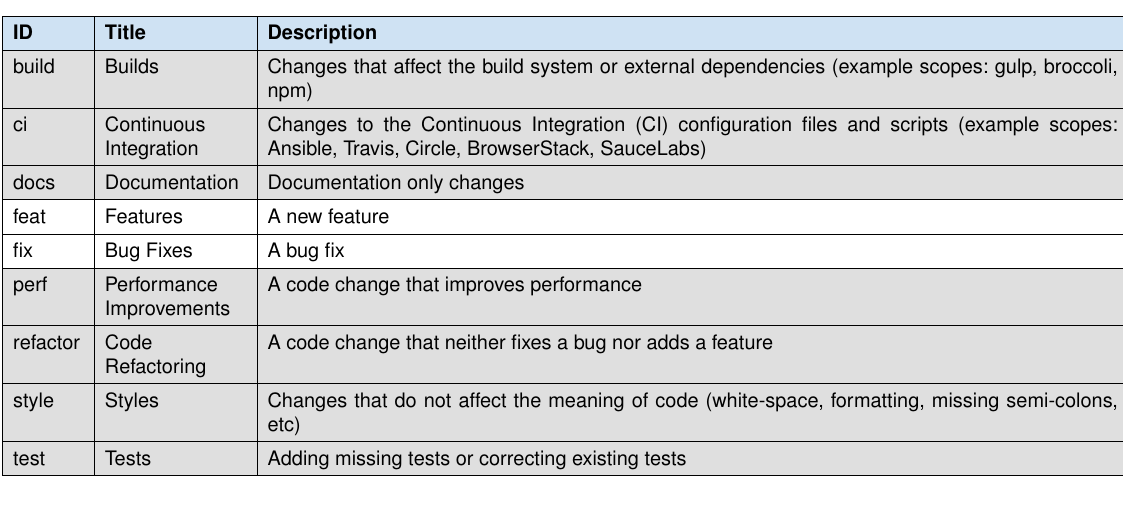
Table 4. Conventional commit types for Git. The most relevant are Features and Bug